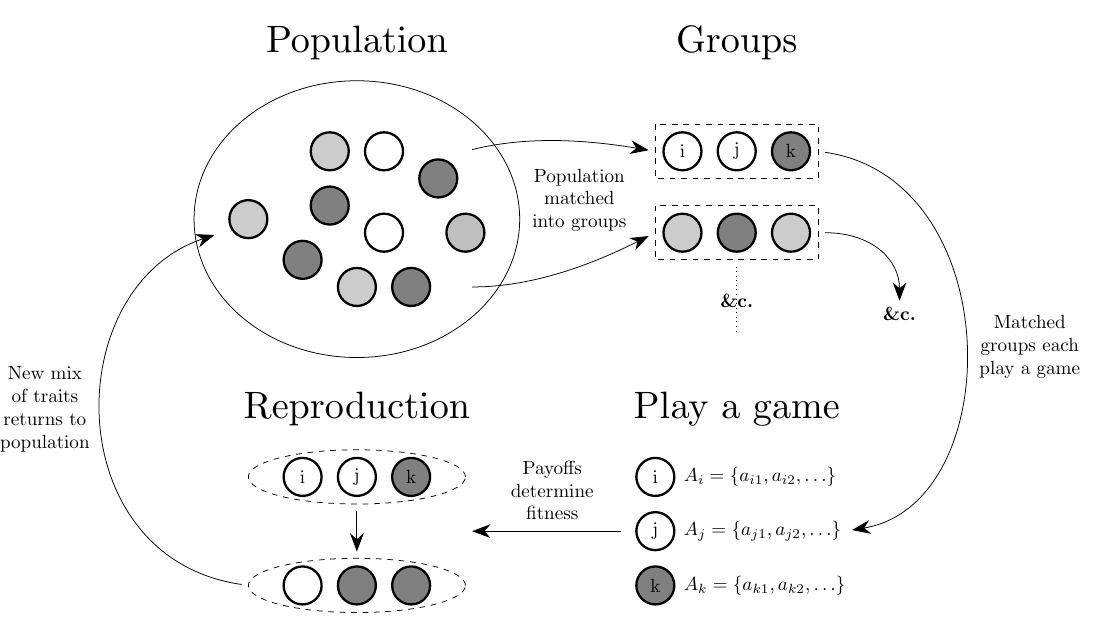
Figure 7. The evolution of behavior. From a population, individuals are matched into groups